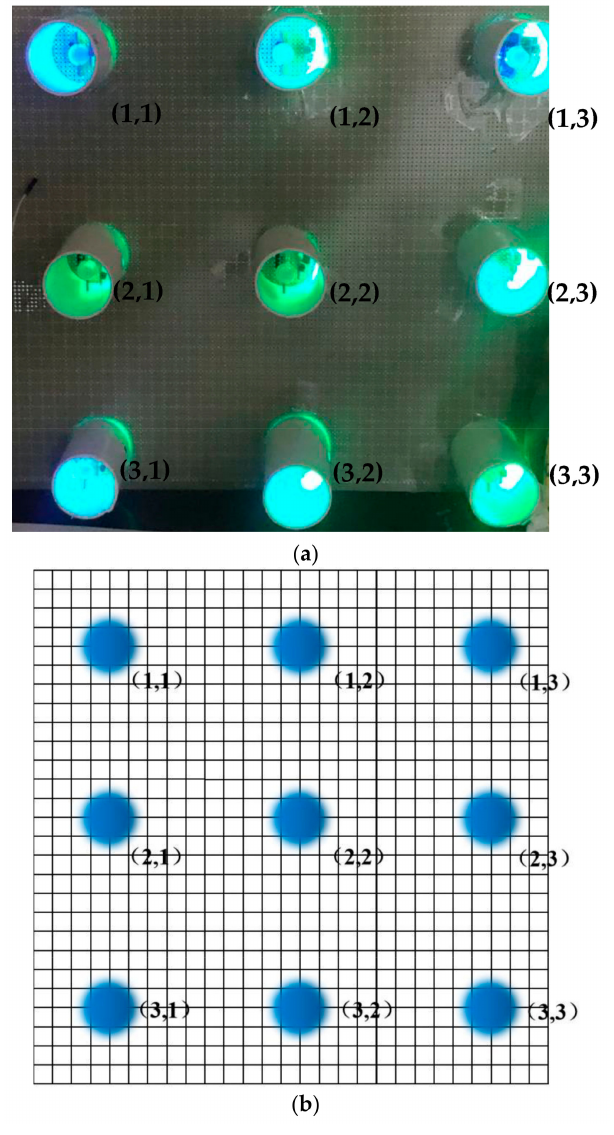
Figure 9. Photoelectric detection device. ( a ) Photoelectric detection experimental device; ( b ) equiva- lent diagram of photoelectric detection experimental